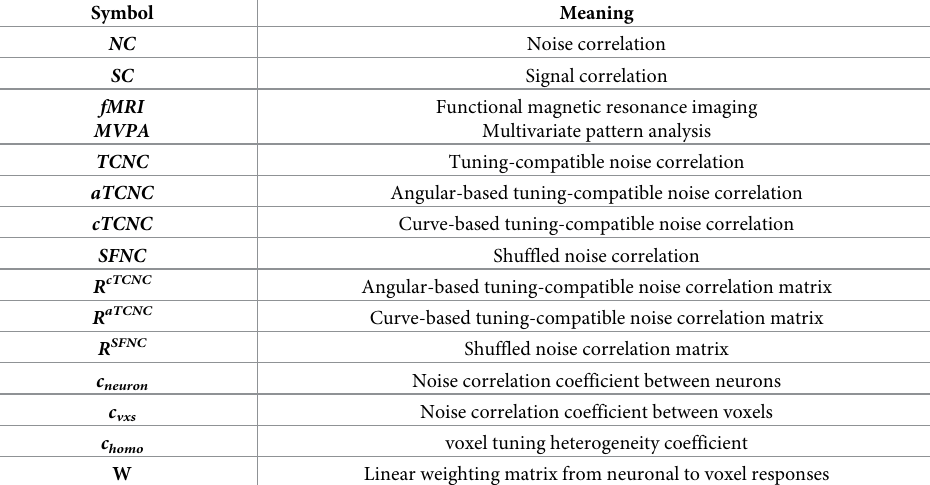
Table 1. List of symbols. Symbol